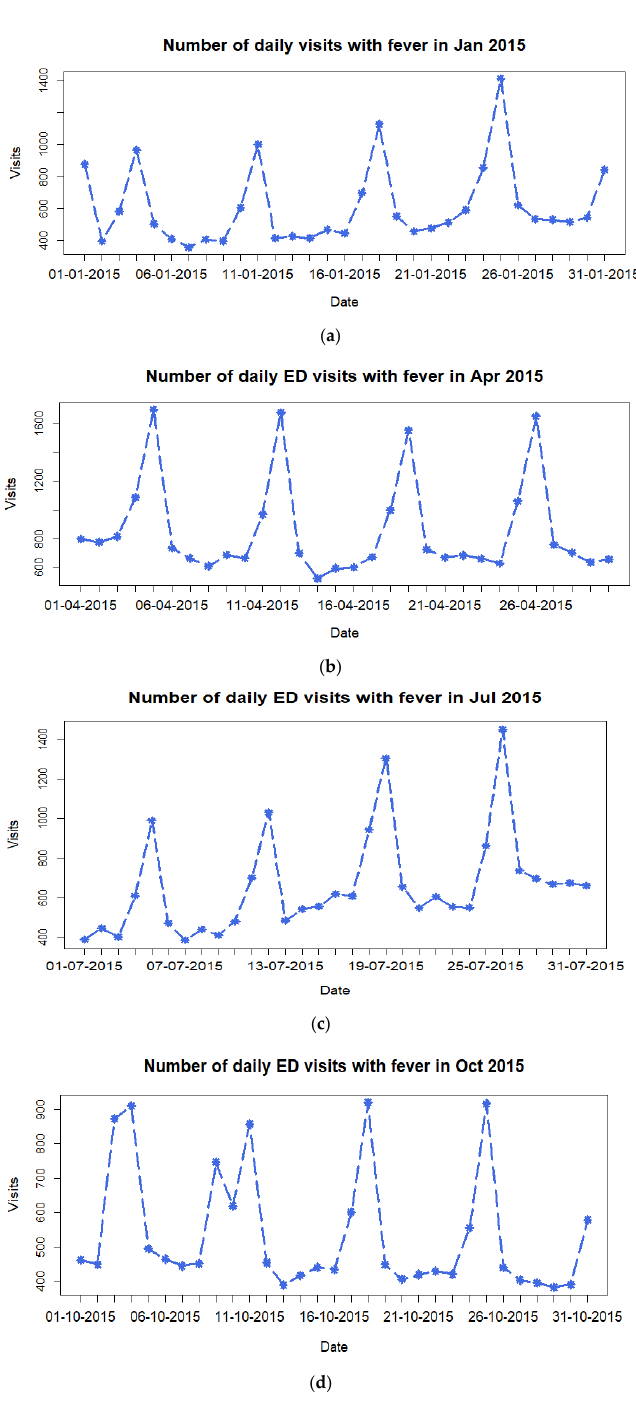
Figure A2. Daily number of ED visits in the first month of the quarter